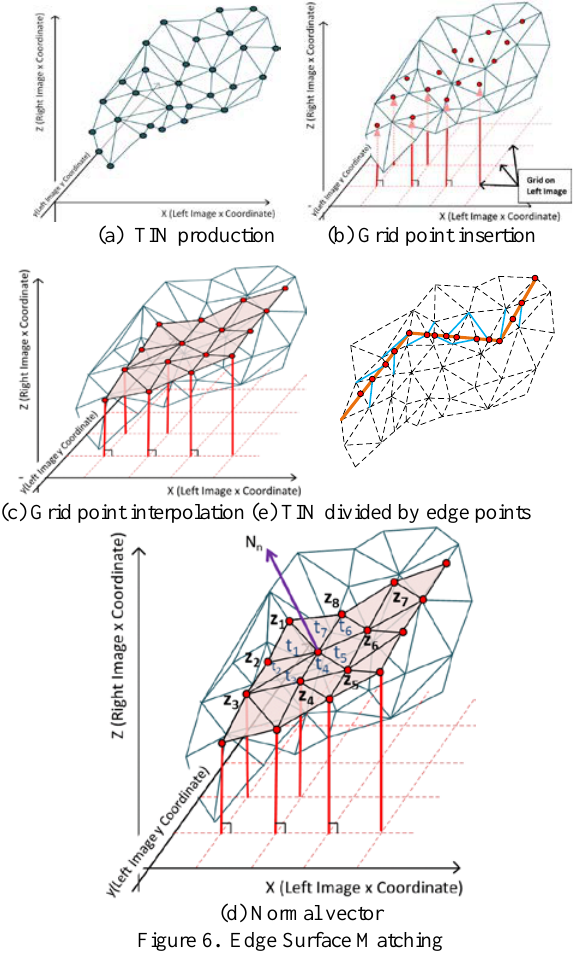
Figure 6 . Edge Surface